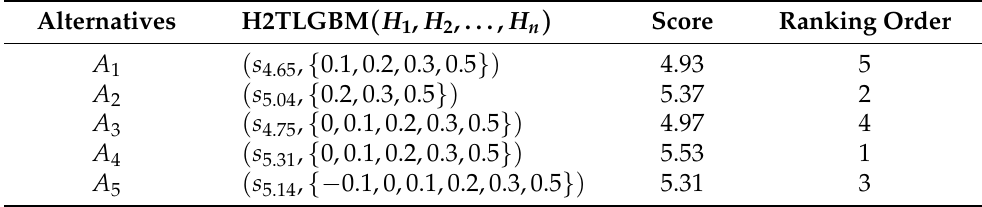
Table 8. Ranking of alternatives by using H2TLGBM operator when p = 1, q =